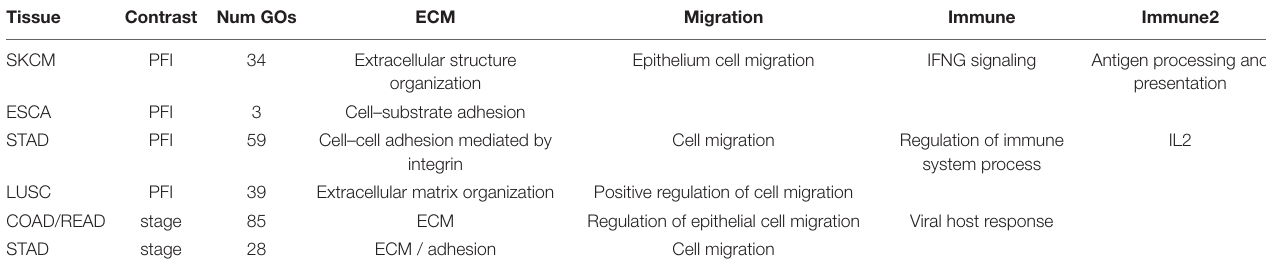
TABLE 3 | Enriched GO terms.